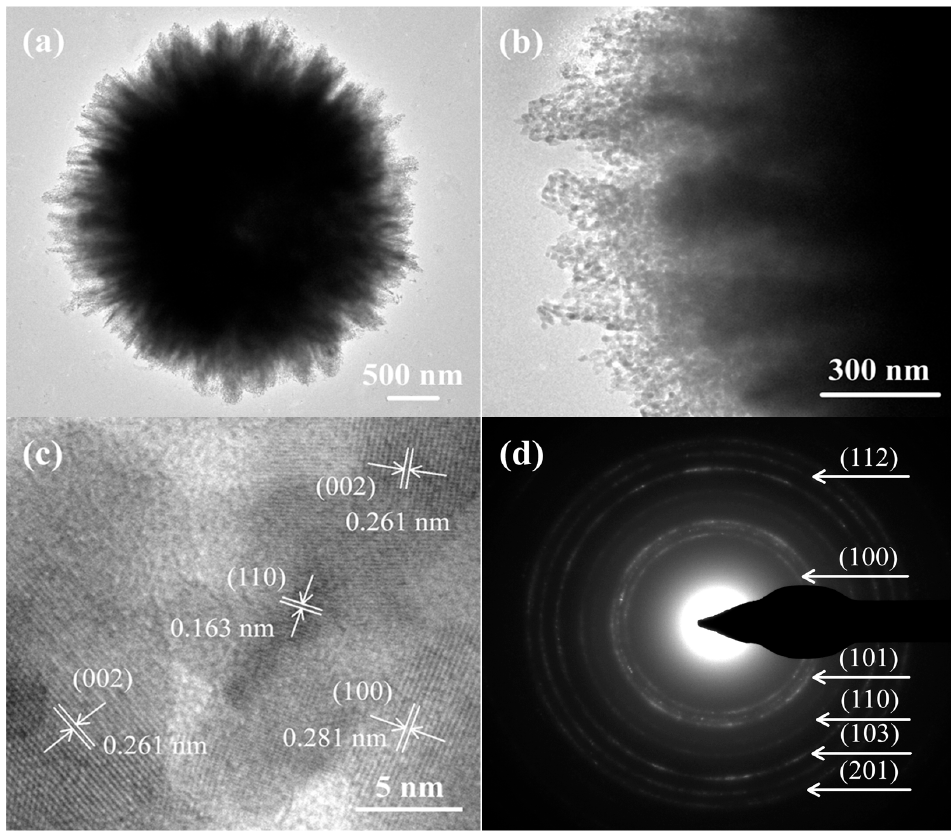
Figure 3. ( a ) TEM image, ( b ) high-magnification TEM image, ( c ) HRTEM image, and ( d ) SAED pattern of 10% Ni-doped ZnO sea urchins.